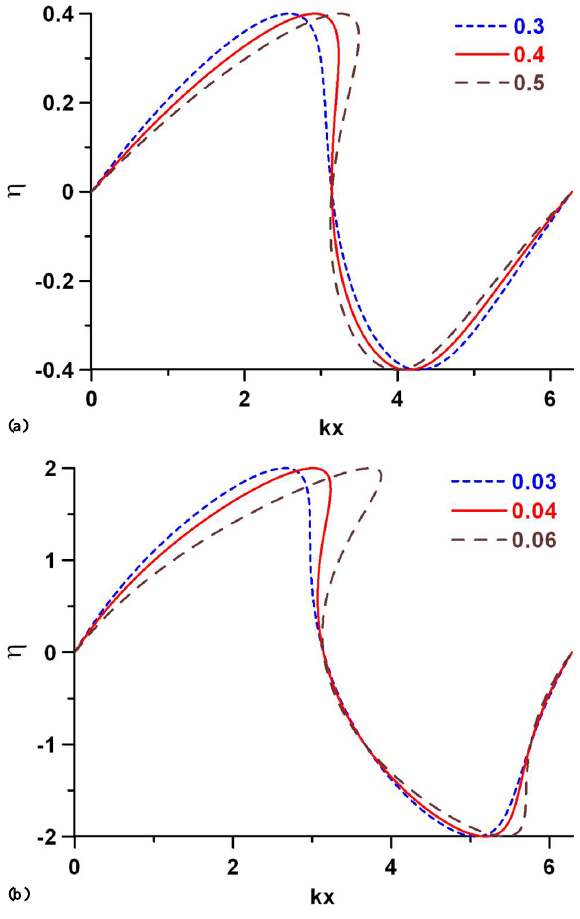
Fig. 3. Nonlinear wave transformation: (a) α > 0, β = 0 (CQ = 0); (b) α = 0, β > 0 (CQ = +∞ ). Breaking time T is T 2 for (a) and T 3 for (b) .